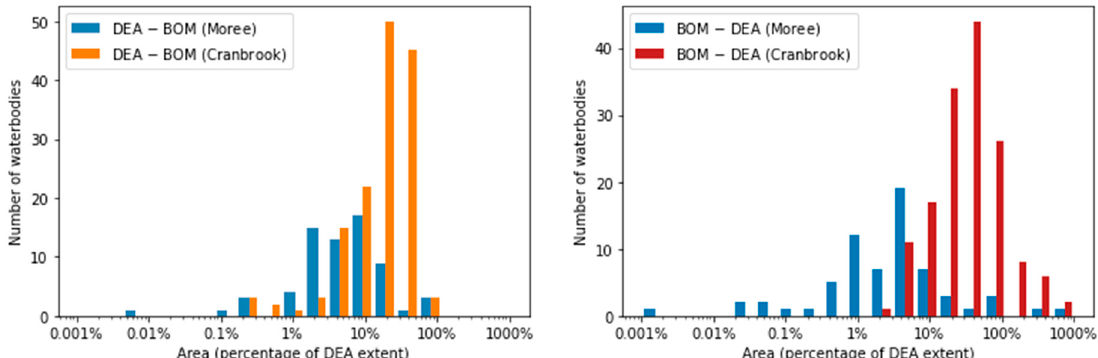
Figure A8. Distribution of areas of the difference polygons between DEA Waterbodies polygons and Geofabric polygons for the Moree and Cranbrook test areas.